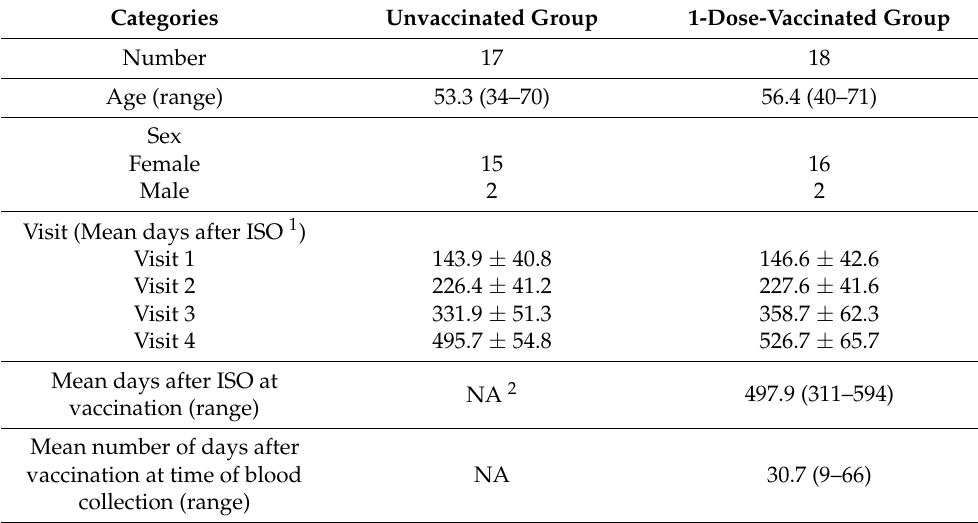
Table 1. Characteristics of SARS-CoV-2-recovered individuals selected for the nested case–control